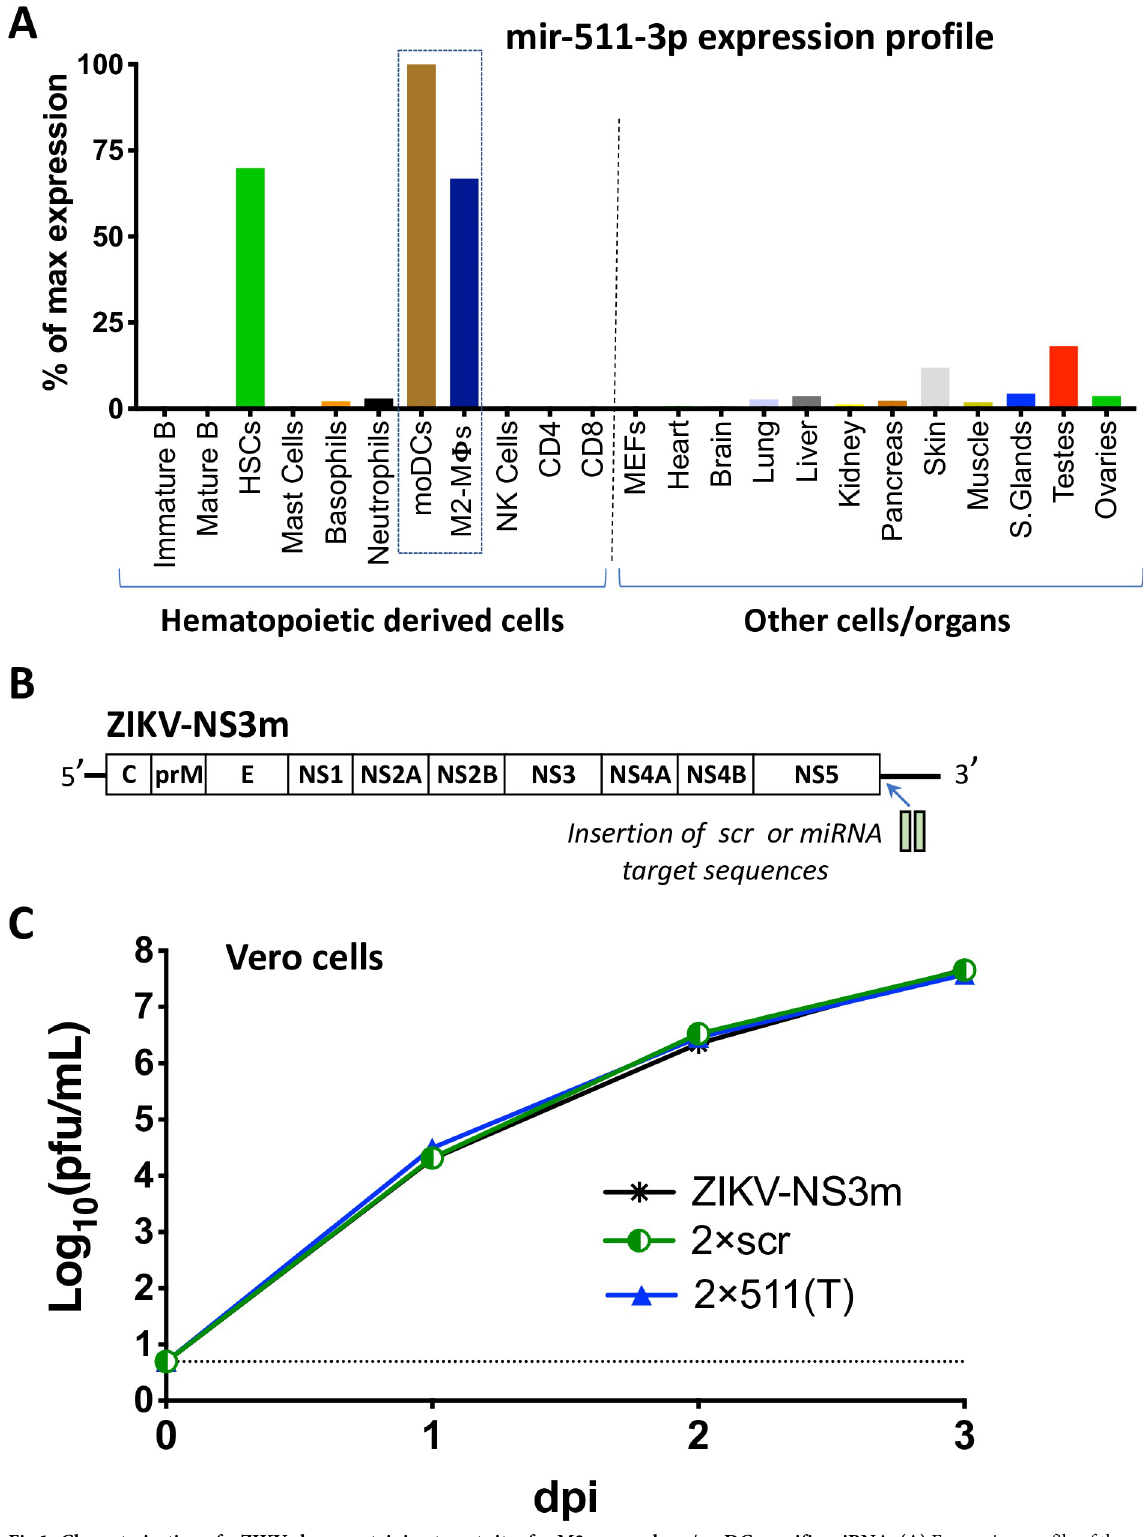
Fig 1. Characterization of a ZIKV clone containing target sites for M2 macrophage/moDC-specific miRNA. (A) Expression profile of the mir-511-3p in selected cells and organs of mice. The graph was constructed based on deep sequencing data of the mouse miRNAs